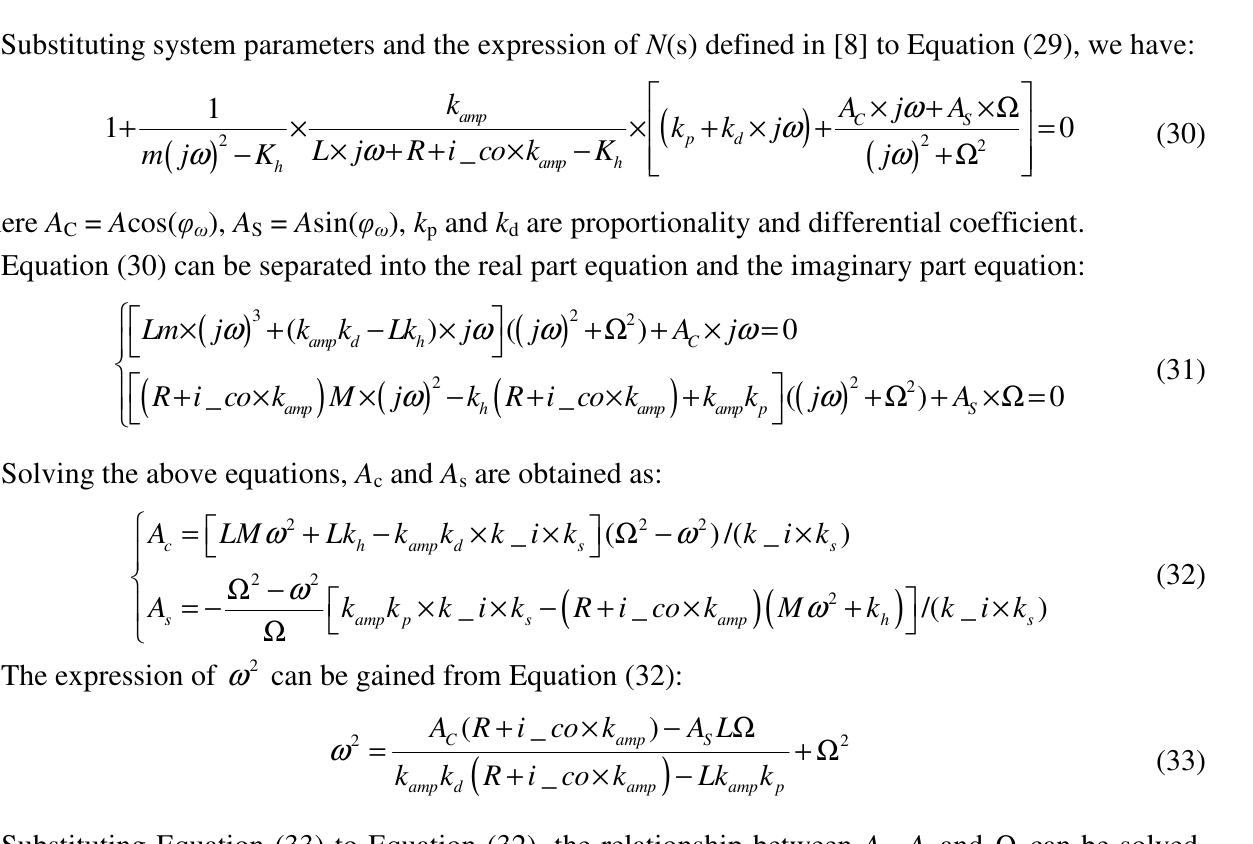
Figure 12. We can see that: (1) stable regions under different speeds are all passing through the origin of coordinates; (2) the stable regions of the low speed and high speed have no intersection, and the low speed and the high speed are separated by the rigid critical